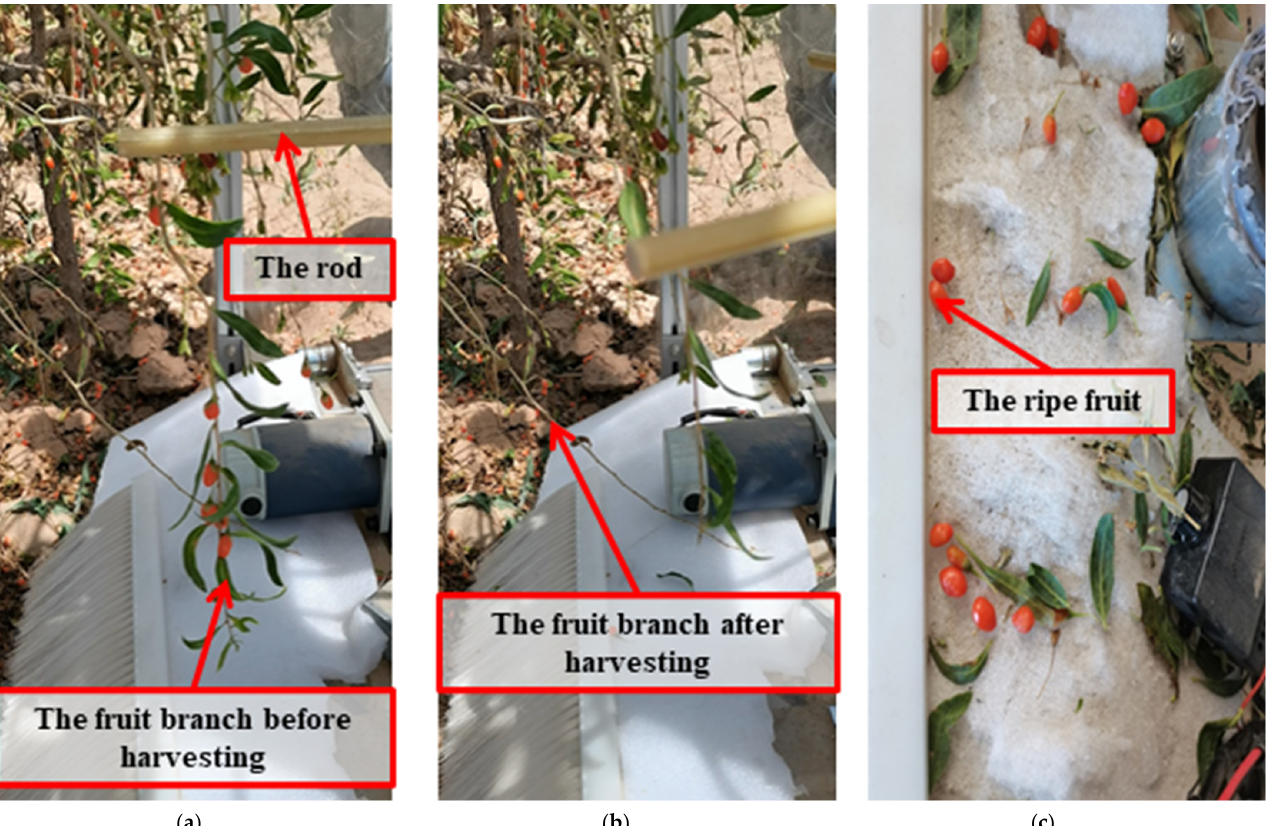
Figure 7. The field experiment before harvesting ( a ) and after harvesting ( b ) and the harvested fruit ( c ).